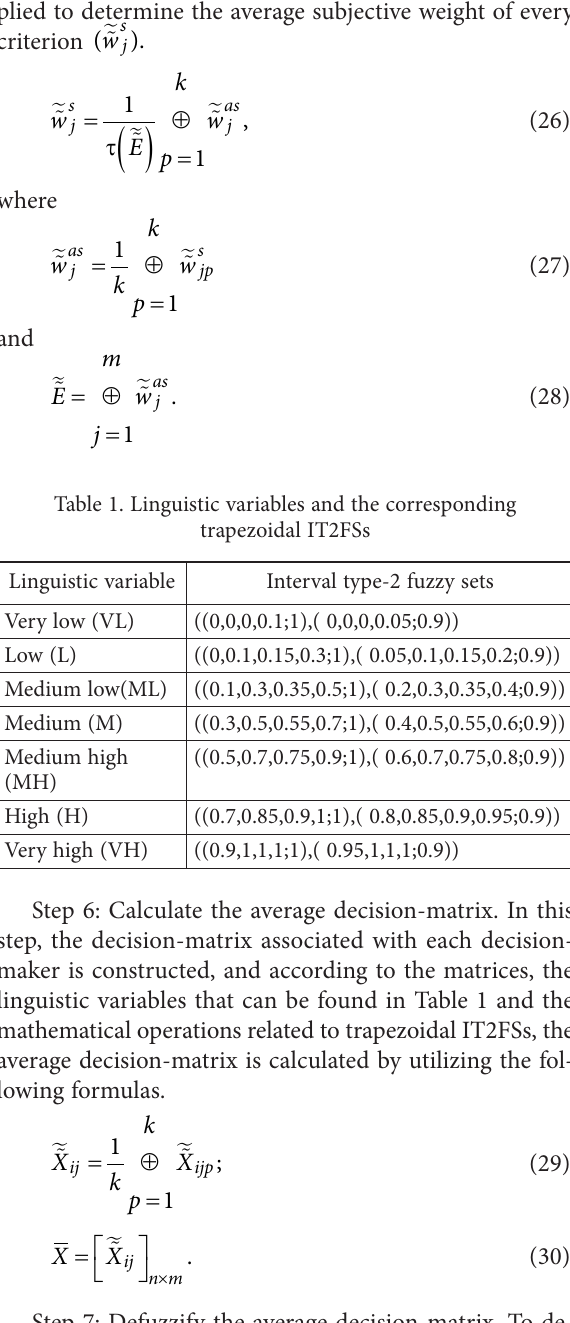
Figure 2. The framework of the proposed evaluation